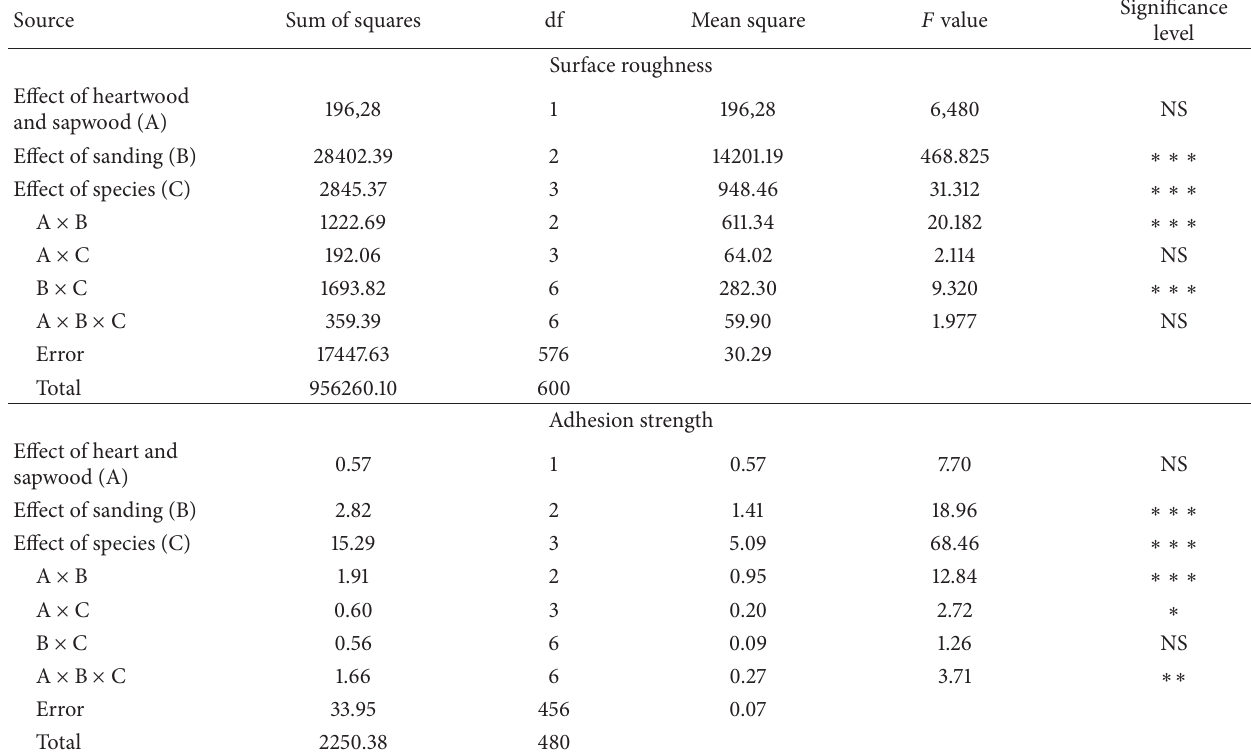
Table 2: Statistical analysis of the roughness and adhesion strength test results.